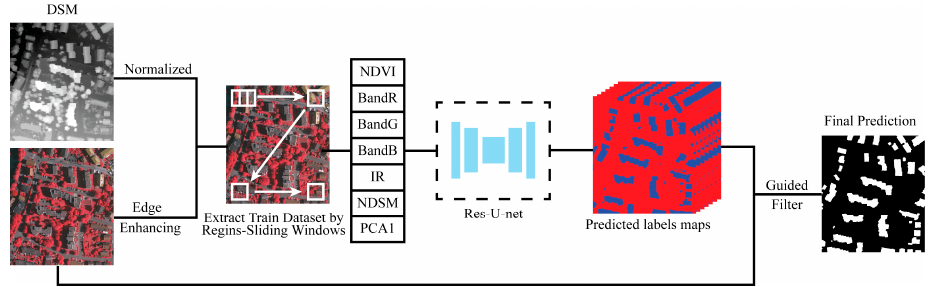
Figure 1. The framework of the pixel classification using deep learning and a guided filter.